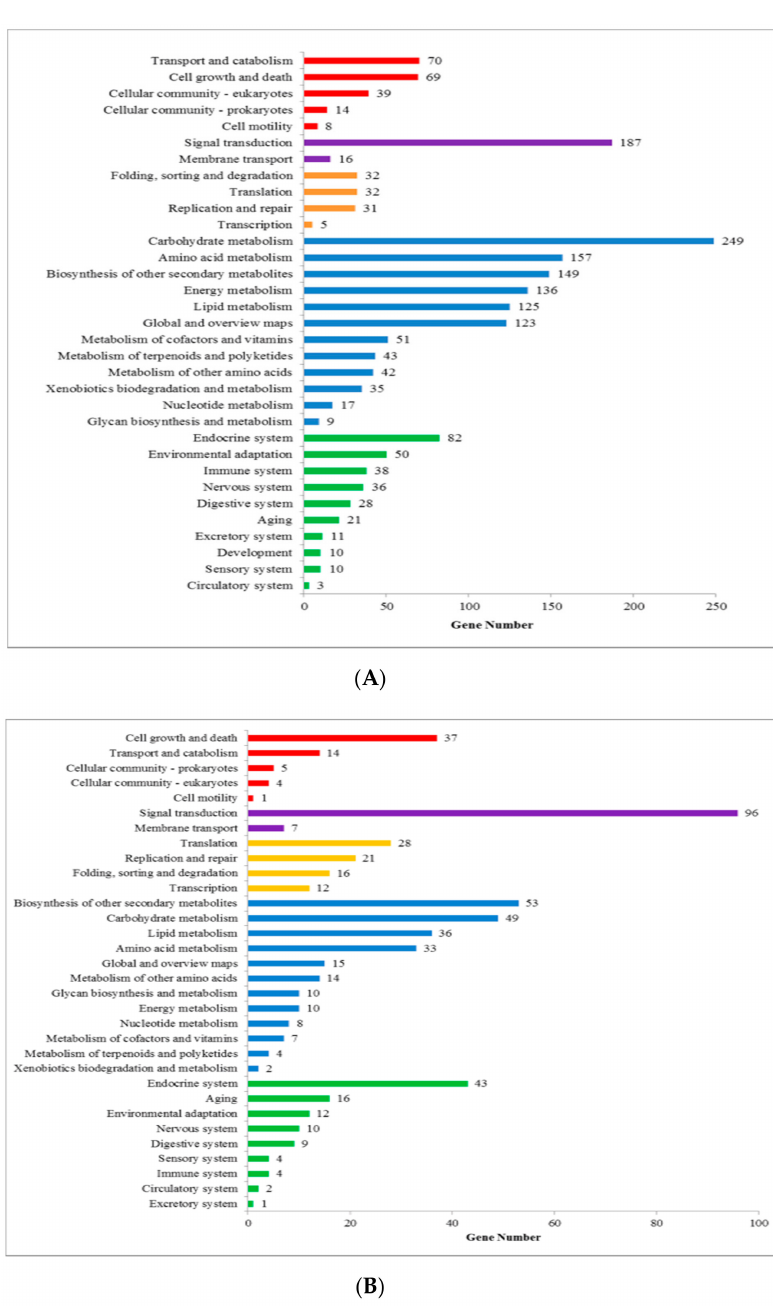
Figure 3. Kyoto Encyclopedia of Genes and Genomes (KEGG) classification: ( A ) SL vs. SR, ( B ) SL vs. TRL. The y -axis represents the names of the 26 groups of the KEGG. The y -axis represents the ratios of the number of annotated genes for each group to the total numbers of annotated genes. Di ff erent colors are used to distinguish di ff erent